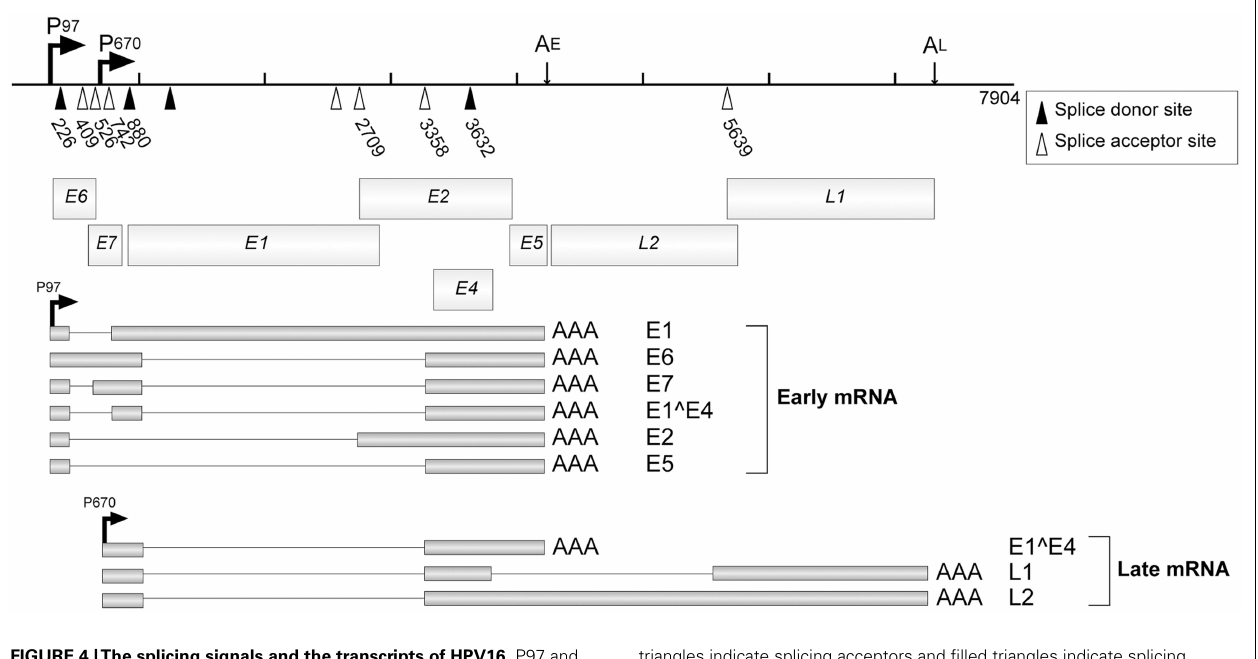
triangles indicate splicing acceptors and filled triangles indicate splicing donors. Major mRNAs and their products are indicated.This figure is cited from a review (Schwartz,